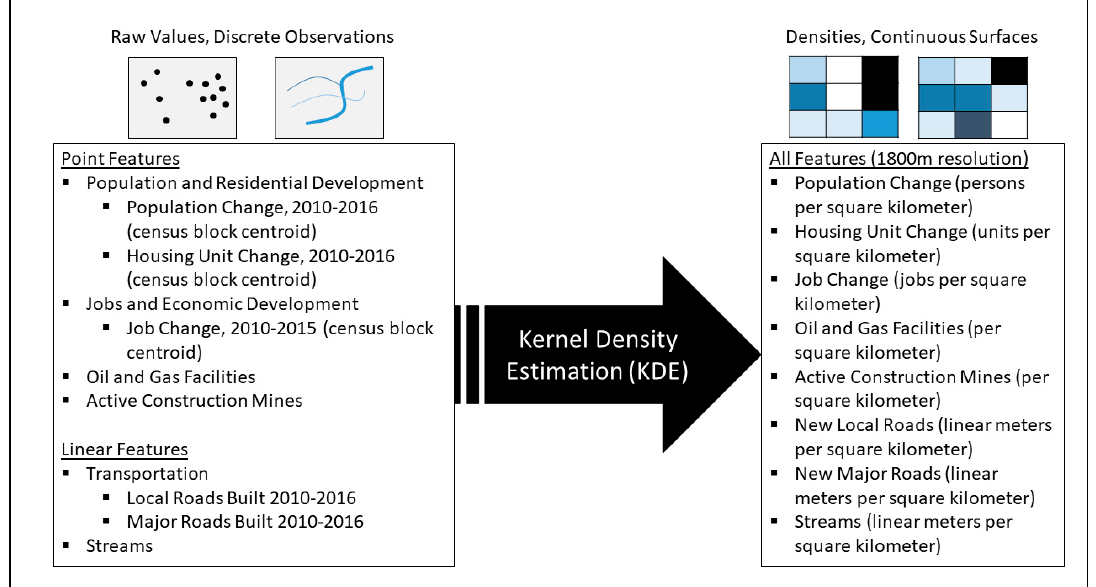
Figure A1. Using KDE to convert discrete feature distributions into equal-resolution surfaces.